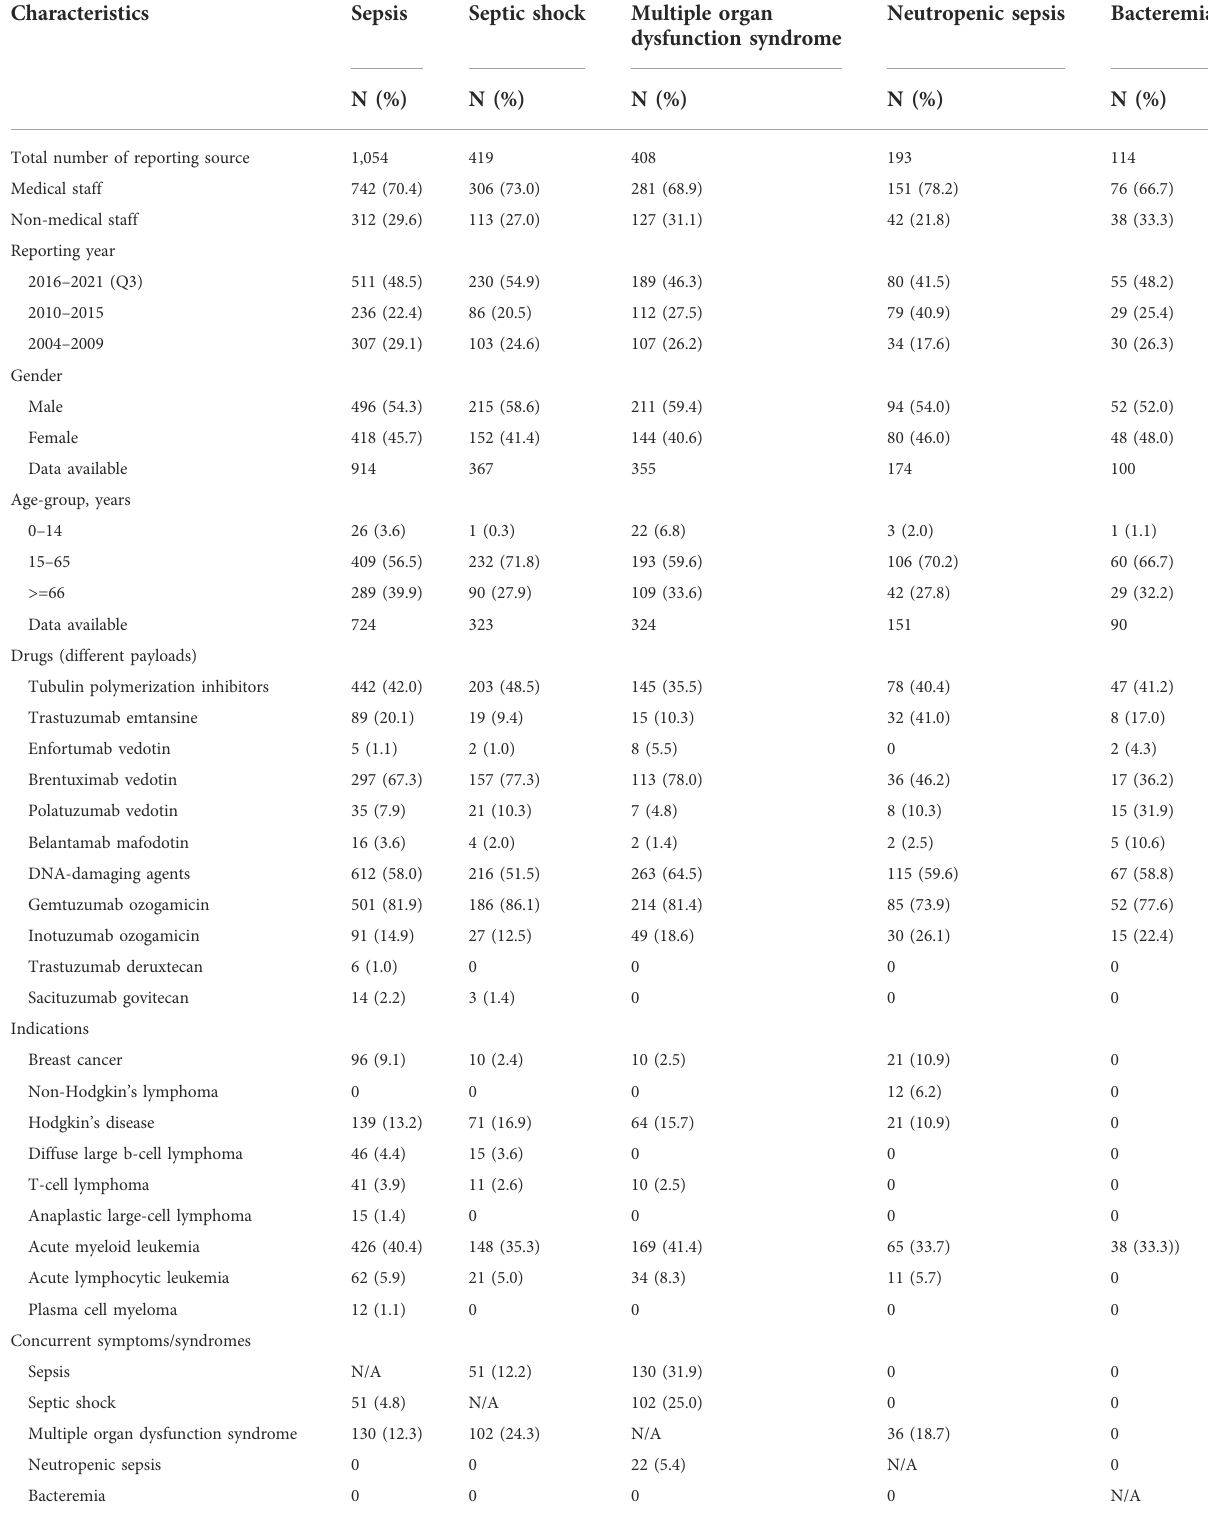
TABLE 2 Clinical characteristics of sepsis-related toxicities correlated with